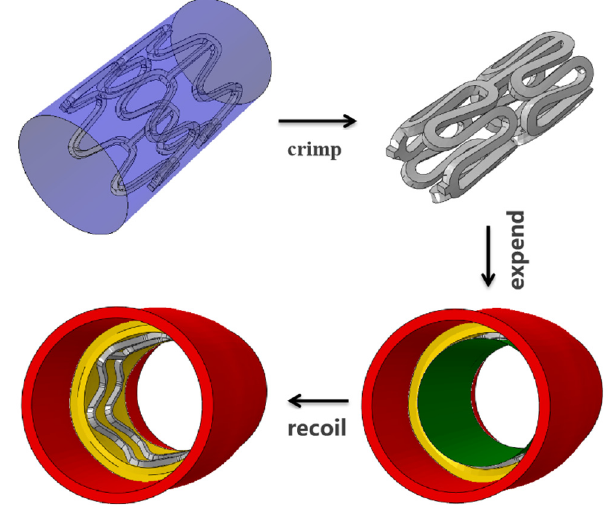
Figure 4. The displacement loading process of a coronary artery stent.